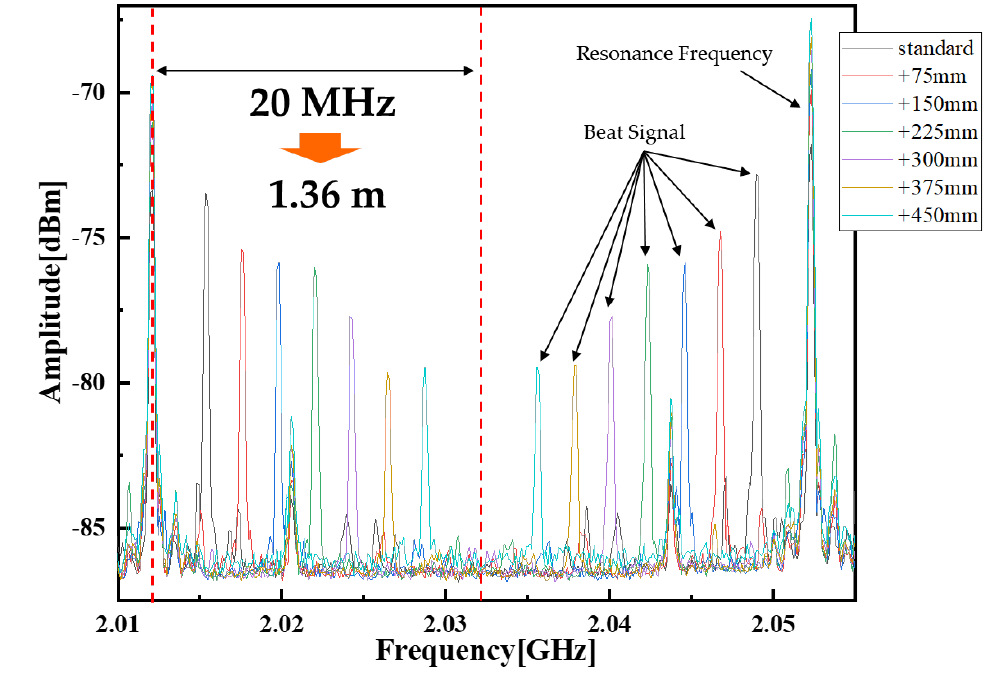
Figure 8. Beat signal spectrum and its frequency variation.